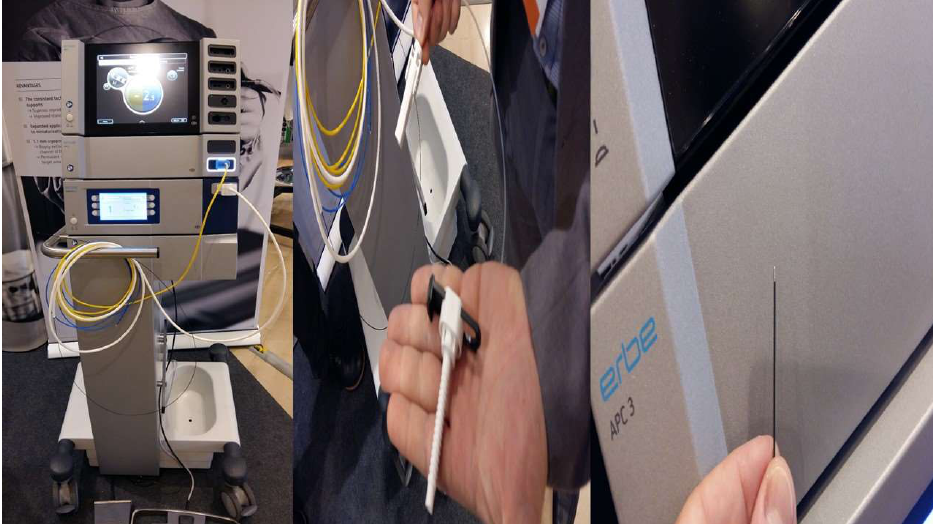
Figure 4. Left: ERBE 2 platform; middle and right: the probe 1.1 mm.